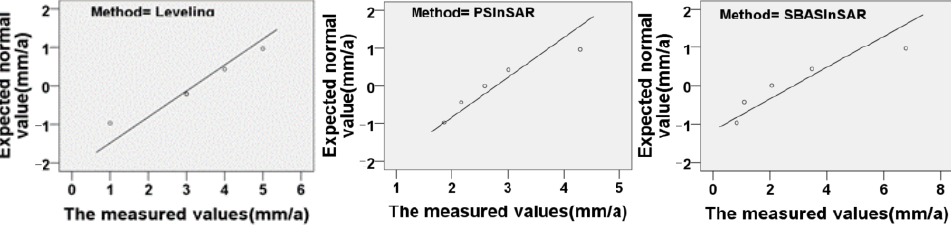
Figure 17. The difference between the three measurements and the normal expected value.